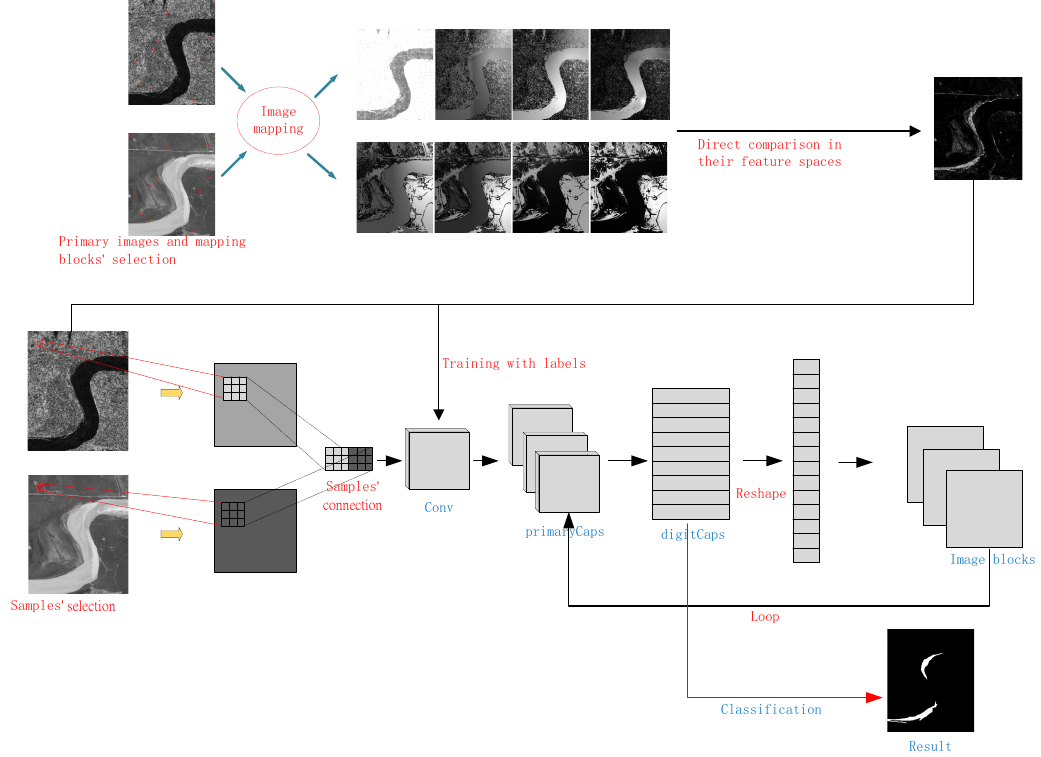
Figure 1. Flowchart of the proposed method for remote sensing image change